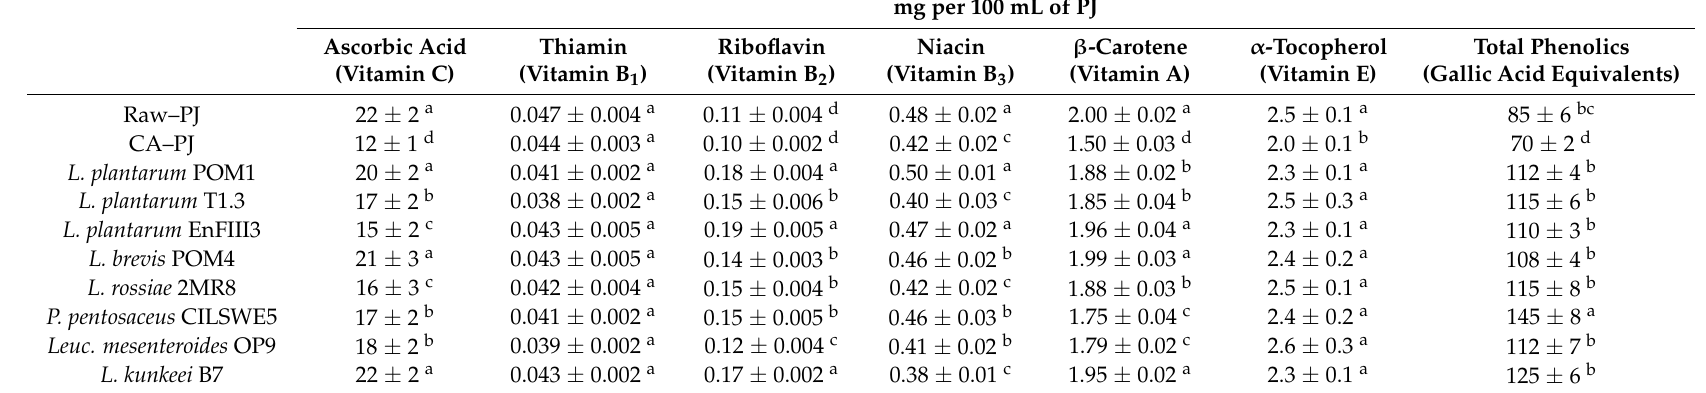
Table 2. Level of vitamins and total phenolics (mg per 100 mL of PJ) in raw Portulaca oleracea L. juice (Raw-PJ), chemically acidified PJ (CA-PJ), and PJs fermented at 30 ◦ C for 36 h by Lactobacillus plantarum POM1, T1.3, and EnFIII3, Lactobacillus brevis POM4, Lactobacillus rossiae 2MR8, Pediococcus pentosaceus CILSWE5,